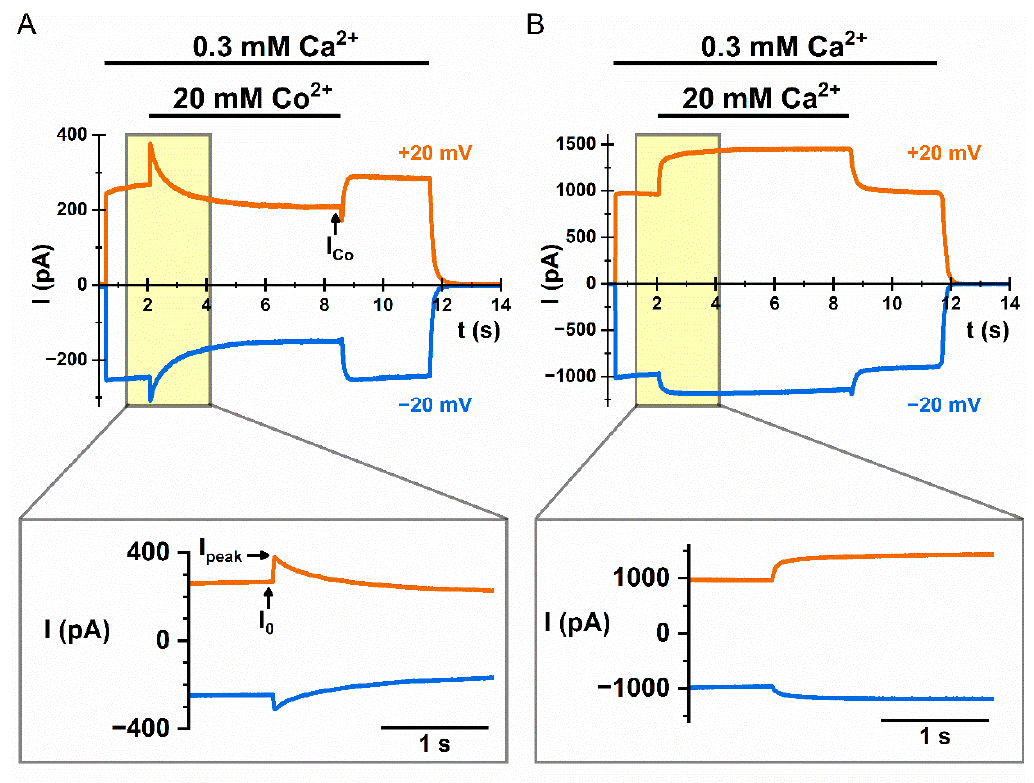
Figure 1. Potentiation of the TMEM16A current by intracellular Co 2+ and Ca 2 + . TMEM16A currents were obtained at voltages clamped at − 20 mV (blue traces) and +20 mV (orange traces). Currents were activated by 0.3 mM intracellular calcium concentration ([Ca 2+ ] i ). ( A ) Recording traces showing the dual effects, inhibition and potentiation on the wild-type TMEM16A (WT 16A ) current by 20 mM intracellular cobalt concentration ([Co 2+ ] i ). ( B ) Recording traces showing potentiation of WT 16A by 20 mM [Ca 2+ ] i . In the bottom panel of both A and B, an expanded view of the yellow shaded area in the upper panel is depicted to focus on the current potentiation. I 0 represents the control current before the application of divalent cations, whereas I peak and I Co represent the peak current after the application of Co 2+ and the quasi-steady-state current at the end of the Co 2+ application, respectively.